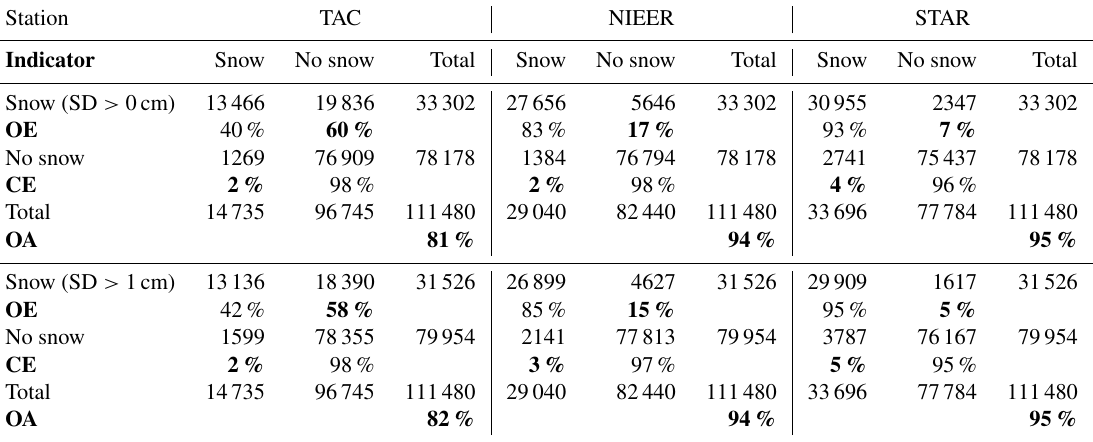
Table 5. Confusion matrices between TAC NDSI, NIEER AVHRR SCE, STAR NDSI datasets and in situ snow-depth (SD) data in NX from 1 January 2001 to 31 August 2007. Note that bold values indicate classification accuracy, including OE, CE, and